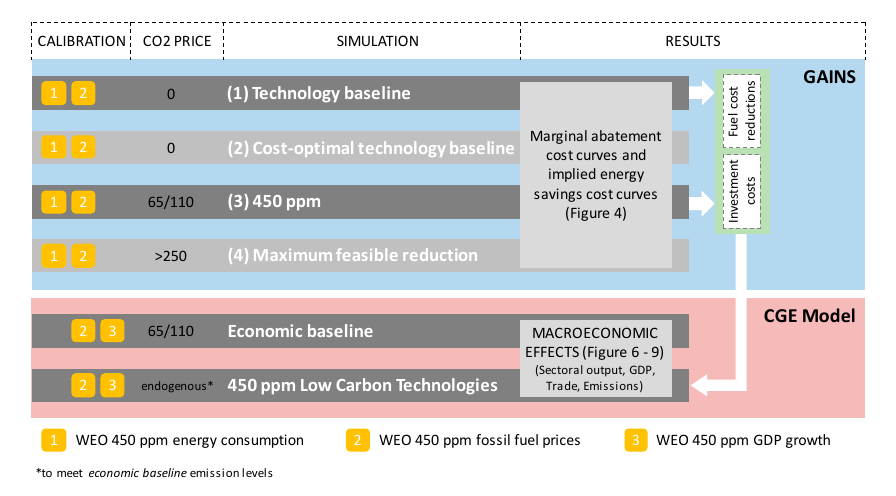
Figure 3. Overview of model calibration and simulations in the technology framework and macroeconomic framework.